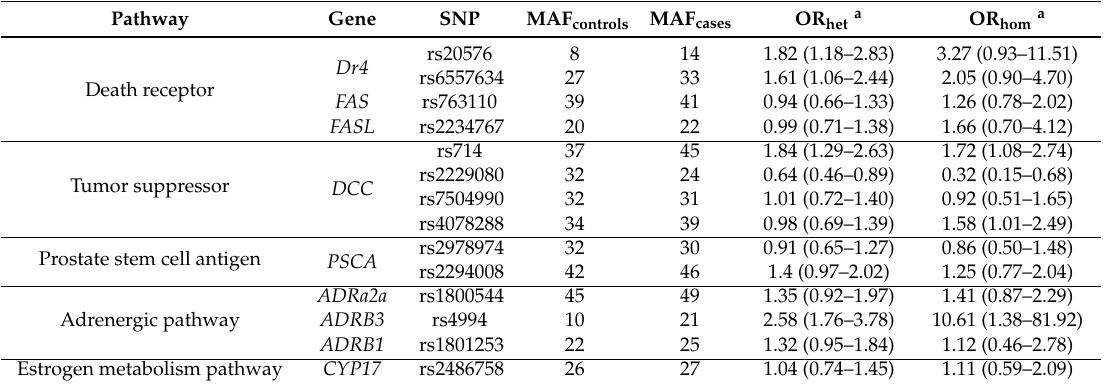
Table 2. Single locus analysis of SNPs investigated.